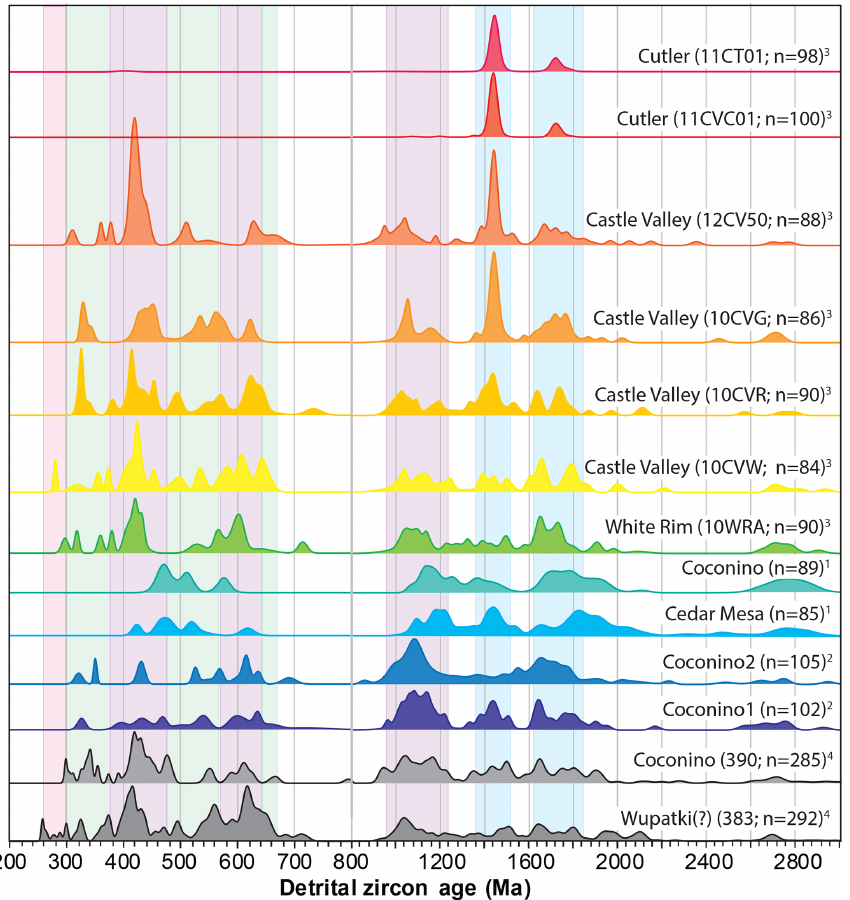
Figure 5. Normalized probability density plots of detrital zircon ages from our sample of the Coconino Sandstone and from other lower Permian sandstones of the Colorado Plateau. Numbers of constituent analyses are shown for each sample. Data are from 1 Dickinson and Gehrels (2003), 2 Gehrels et al. (2011), 3 Lawton et al. (2015), and 4 this study. Shown for reference are age ranges from the Appalachian orogen (purple bands) and from local basement rocks (blue bands) (from Fig. 3), which are interpreted by previous researchers to have sourced most of the detritus in these units. Also shown is our sample 383-2, which is interpreted to belong to the Wupatki Member of the Moenkopi Formation but has an age signature characteristic of lower Permian strata of the Colorado